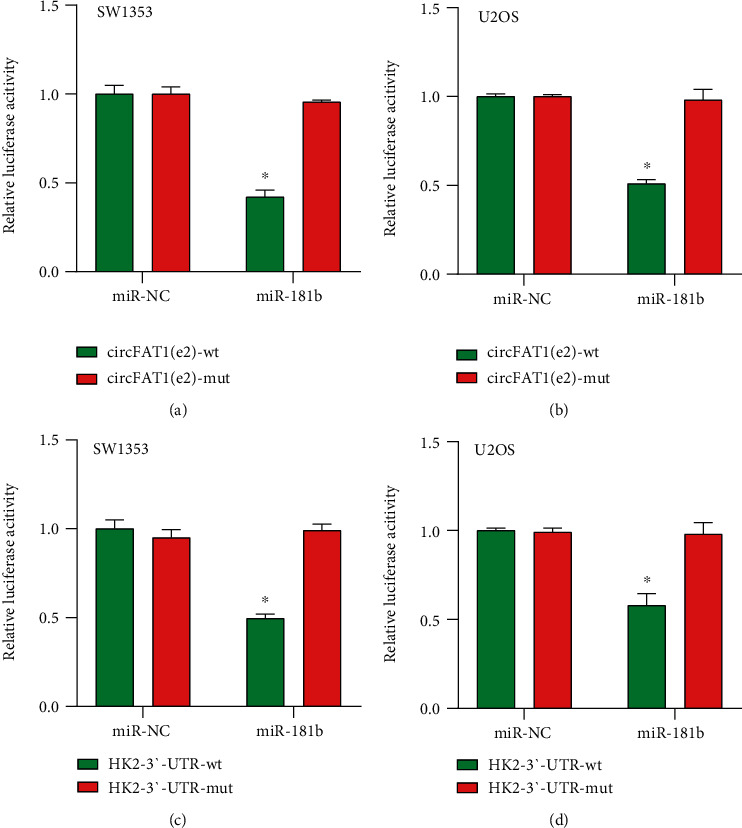
CircFAT1(e2) acted as a sponge for miR-181b, and HK2 was a target of miR-181b. (a, b) The luciferase reporter assays in SW1353 and U2OS cells cotransfected with wild-type circFAT1(e2) luciferase vector and miR-181b mimics, and other cotransfection groups. (c, d) The luciferase reporter assays in SW1353 and U2OS cells with four different co-transfection groups. Error bars represent the mean ± SD of at least three independent experiments. ∗p < 0.05, ∗∗p < 0.01 vs. control group.